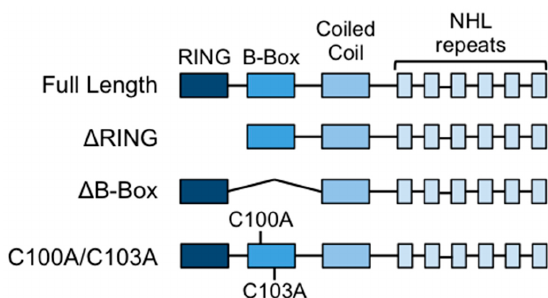
Figure 1. Schematic diagram showing the domain structure of TRIM32 and the deletion/point mutants used in this study.